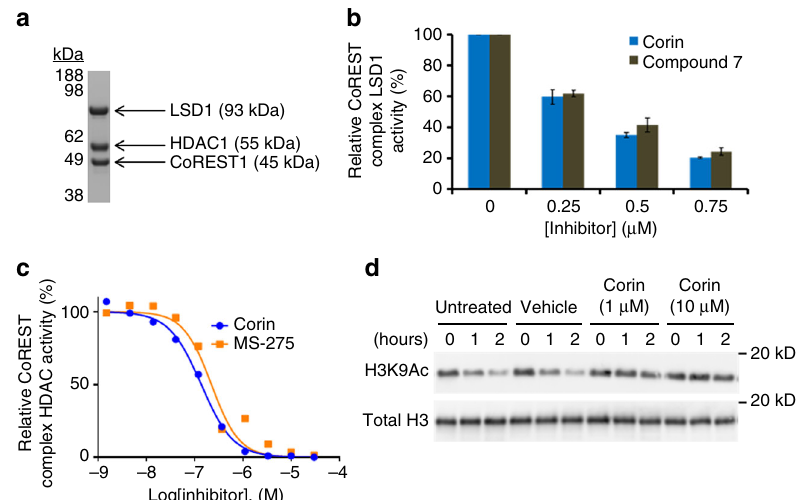
Fig. 2 Dual inhibitors exhibit unique activity against the CoREST complex. a Coomassie stained gel depicting the three components of the CoREST ternary complex after puri fi cation by size exclusion chromatography. b Dose response produced by inhibition of LSD1 as part of the CoREST complex by corin and structurally matched compound 7 . c Inhibition curves generated for corin and MS-275 against HDAC1 as part of the CoREST complex. d Corin inhibited the deacetylation of reconstituted nucleosomes by the CoREST complex as determined by Western blot (CoREST complex = 100 nM, nucleosome = 100 nM). Data (mean ± SEM) are representative of at least two independent experiments